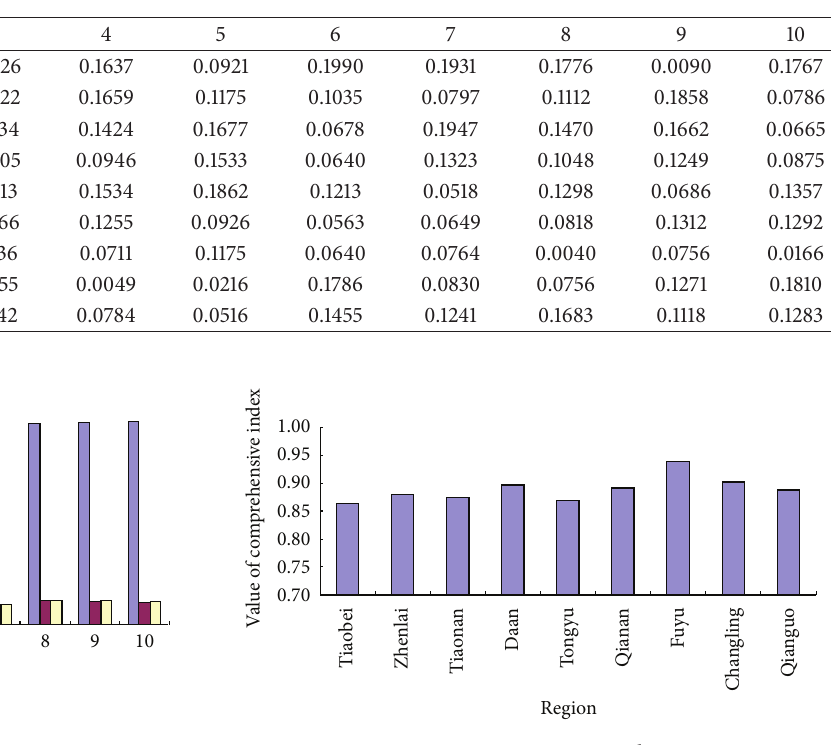
Table 4: Determination of the index weight values.